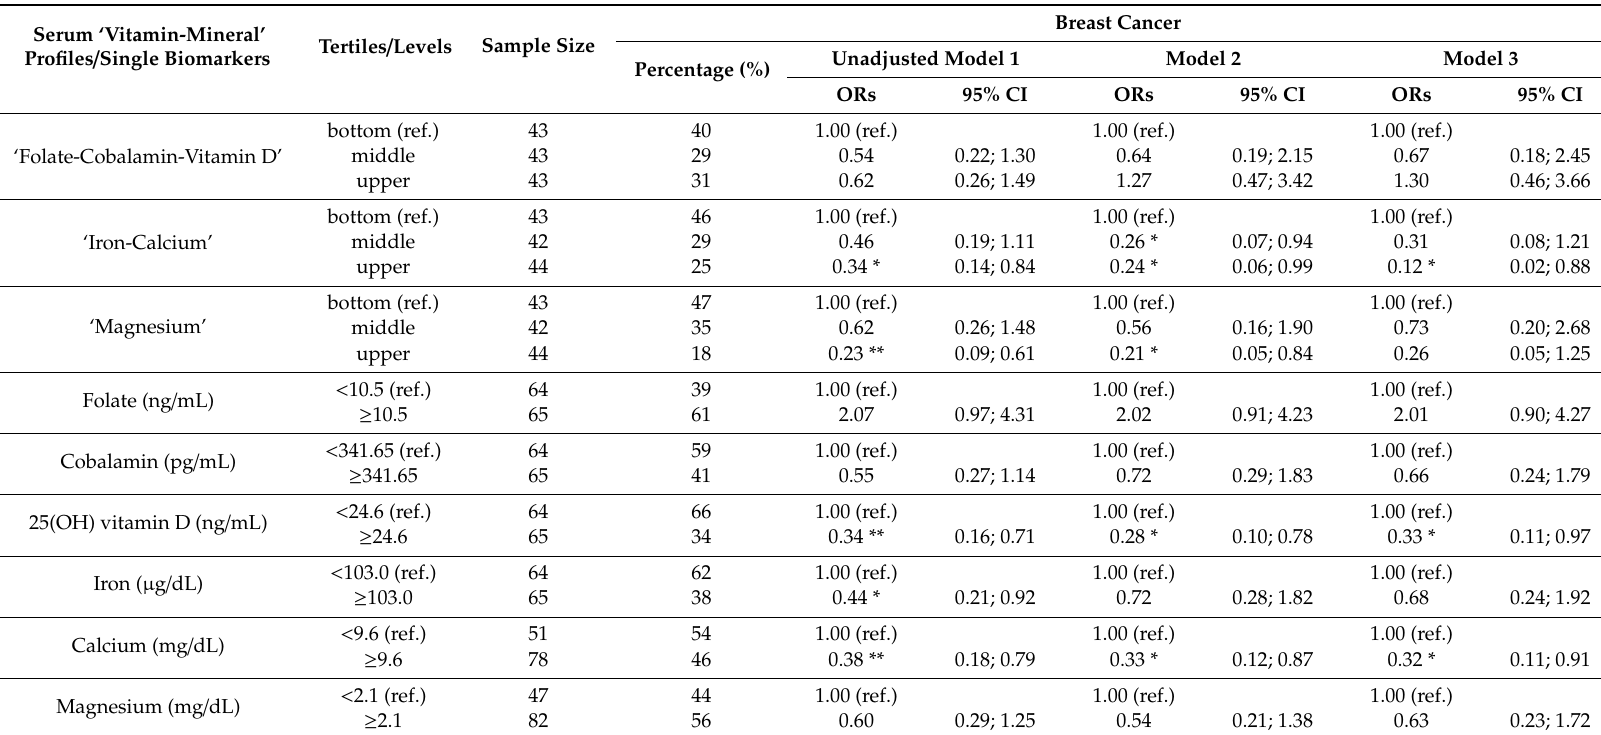
ref.—referent, the reference categories were the control sample and the bottom tertile of serum ‘Vitamin-Mineral’ profiles or lowest level of each single serum biomarkers; Model 2—age (years), BMI (kg / m 2 ), socioeconomic status (low, average, high), overall physical activity (low, moderate, high), smoking status (non-smoker, smoker), age at menarche ( <